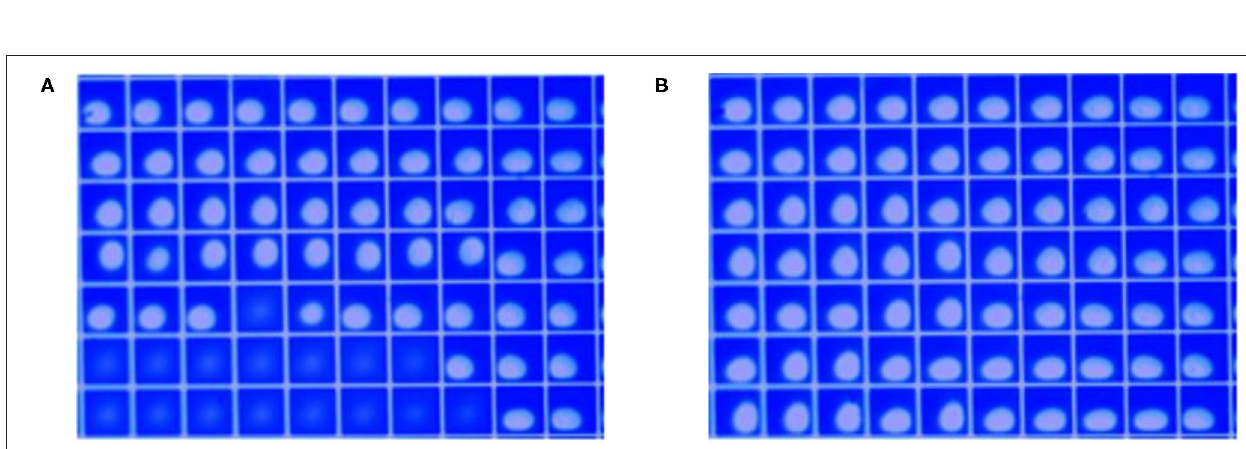
to EWDs system to achieve more accurate control for displaying